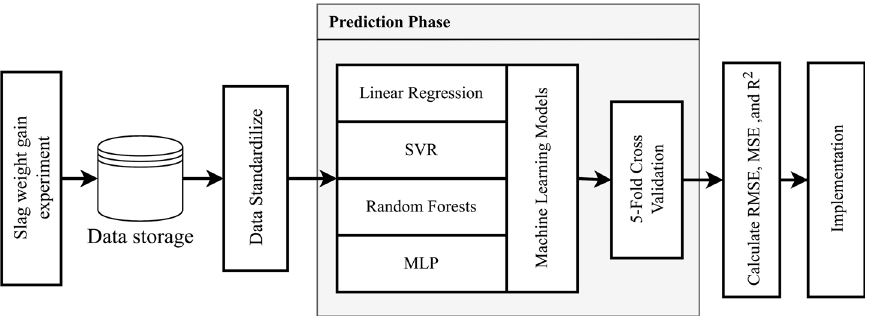
Figure 2. Research process overview.